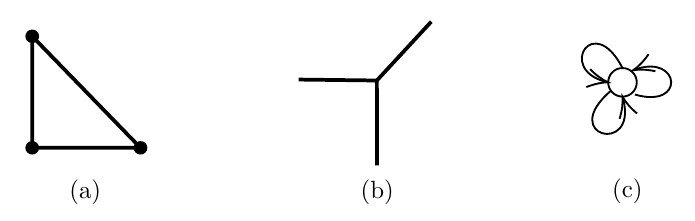
Figure 1 . (a) The toric diagram for C 3 . (b) Its dual web diagram. (c) The C 3